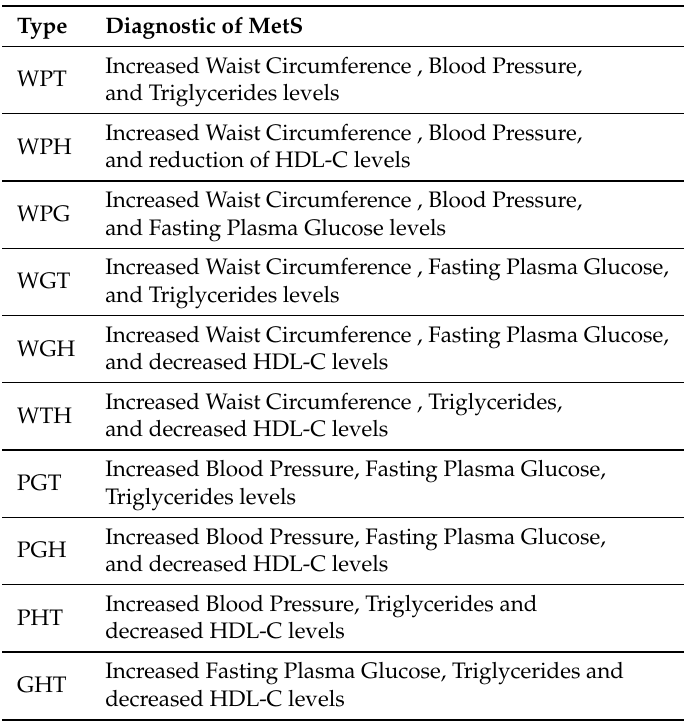
Table 4. Types of MetS according to the HMS